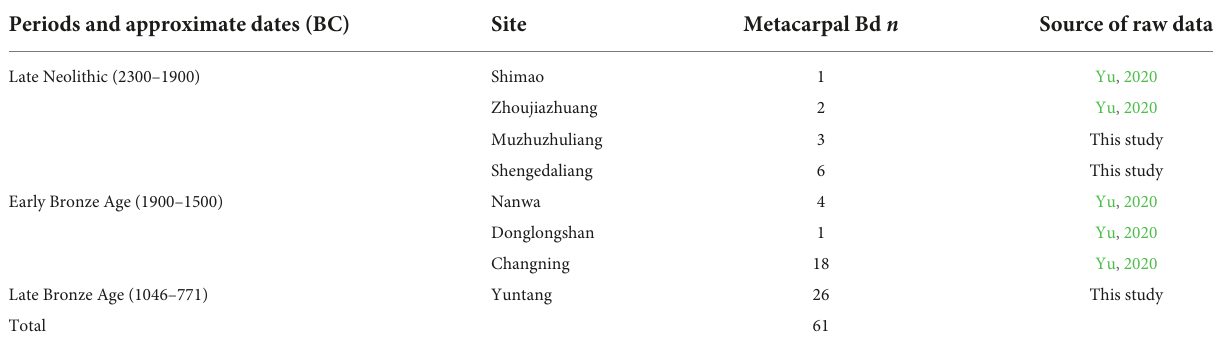
TABLE 1 Sample sources for the Late Neolithic to the Late Bronze Age